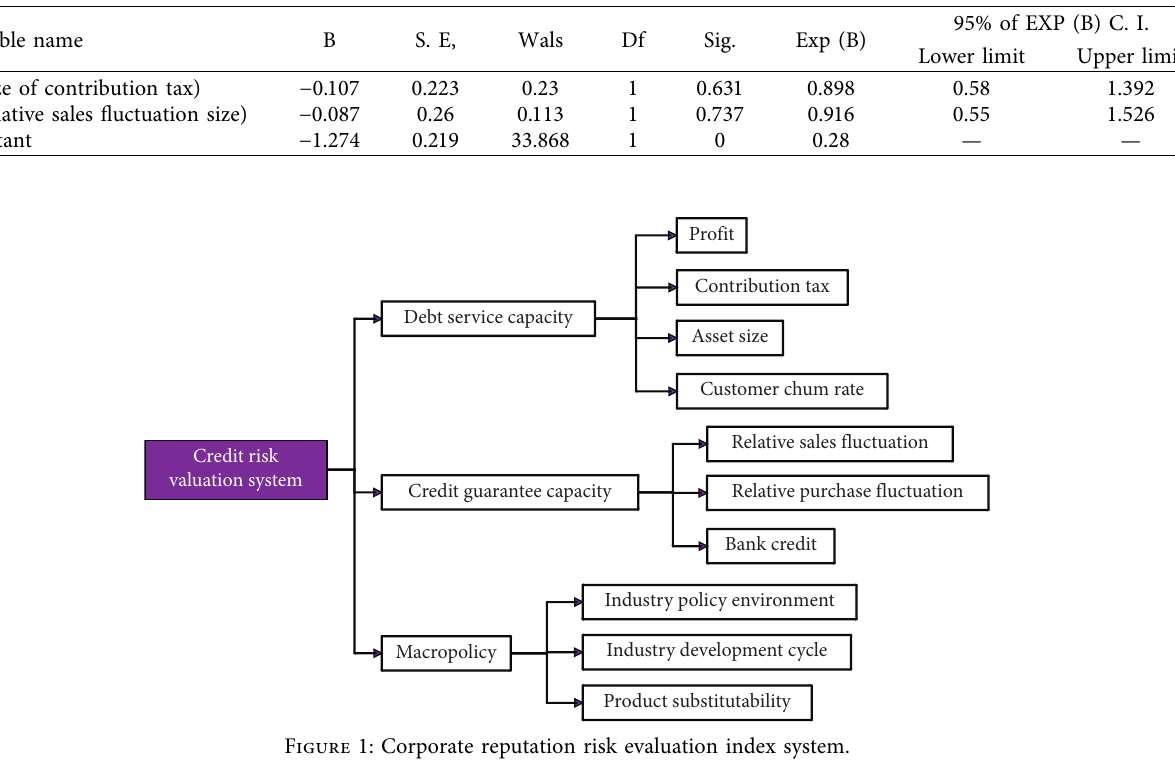
Table 2: Variable coefficients in the equation.